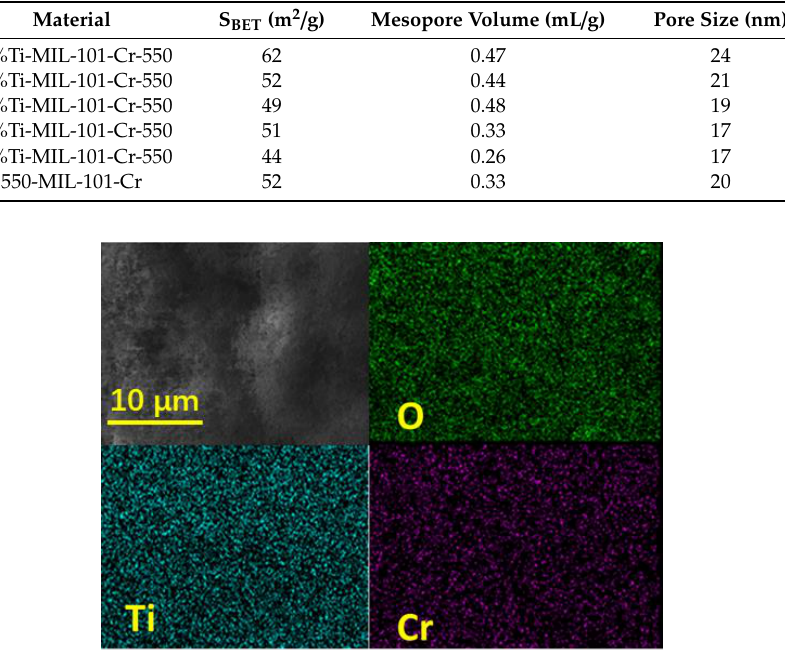
Figure 3. SEM-EDX elemental mapping image of 50%Ti-MIL-101-550.